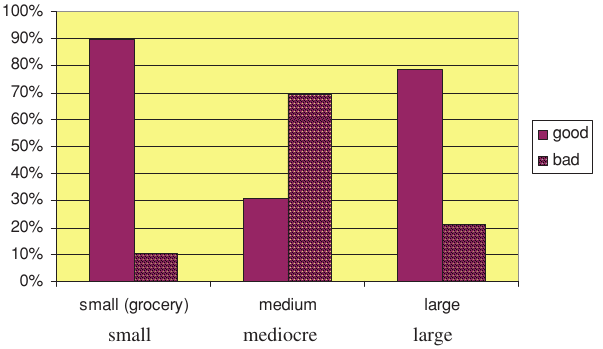
Figure 4. The distribution of quality in sour cherry offered in retail markets of different size Source: origina